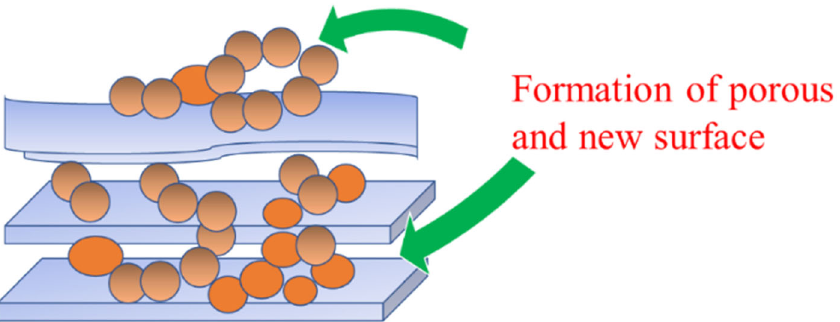
Figure 5. The possible formation of porous structures and new surfaces as adsorption sites by metal/metal oxide